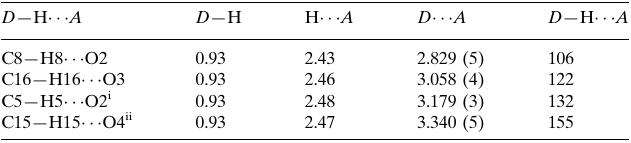
Hydrogen-bond geometry (A˚ , (cid:1)